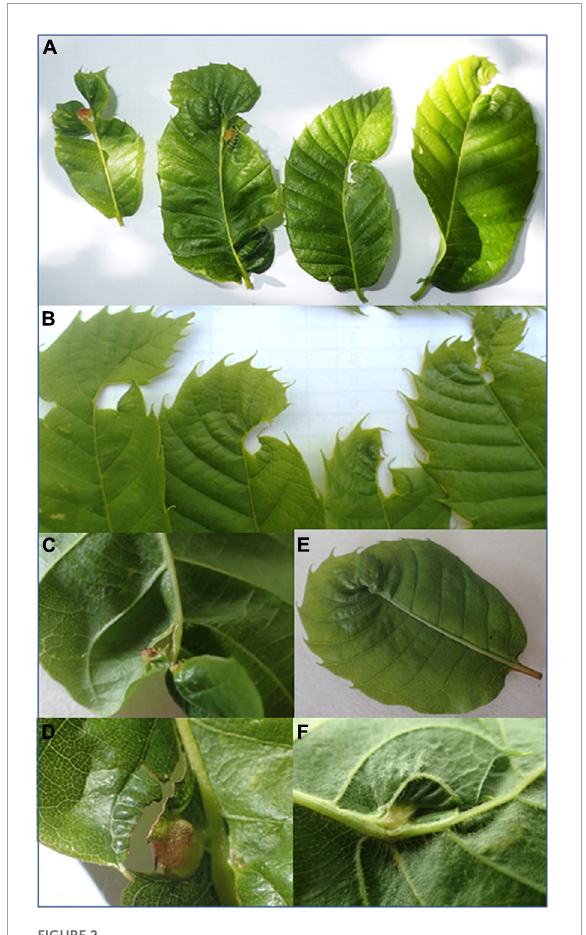
FIGURE2 Spring leaves of Resistant Type I: (A) Small galls in the leaves (left) and empty areas after gall drop (right). (B) Close up of abscised gall zones. (C,D) Gall detaching from the leave (gall abscission). (E,F) Deformed leave with small galls without larvae inside.